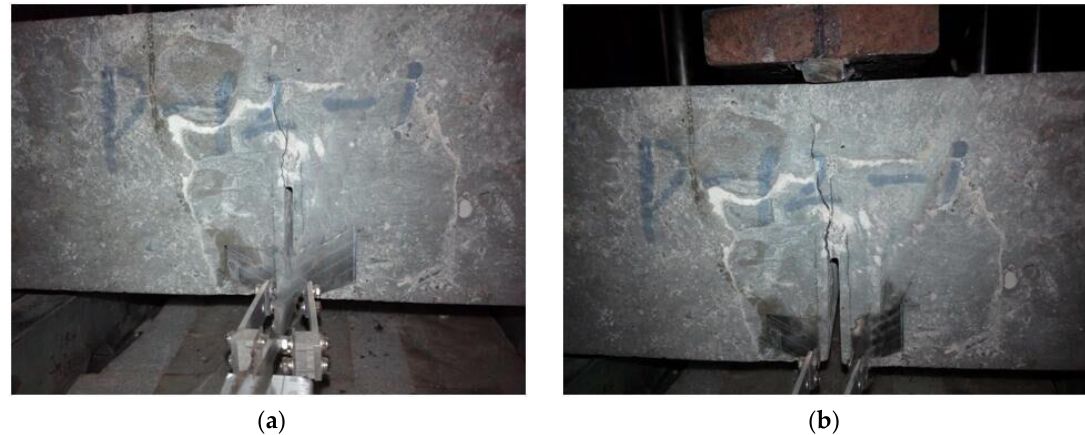
Figure 6. Fracture propagation process: ( a ) Initial fracture morphology, ( b ) fracture morphology in unstable stage.